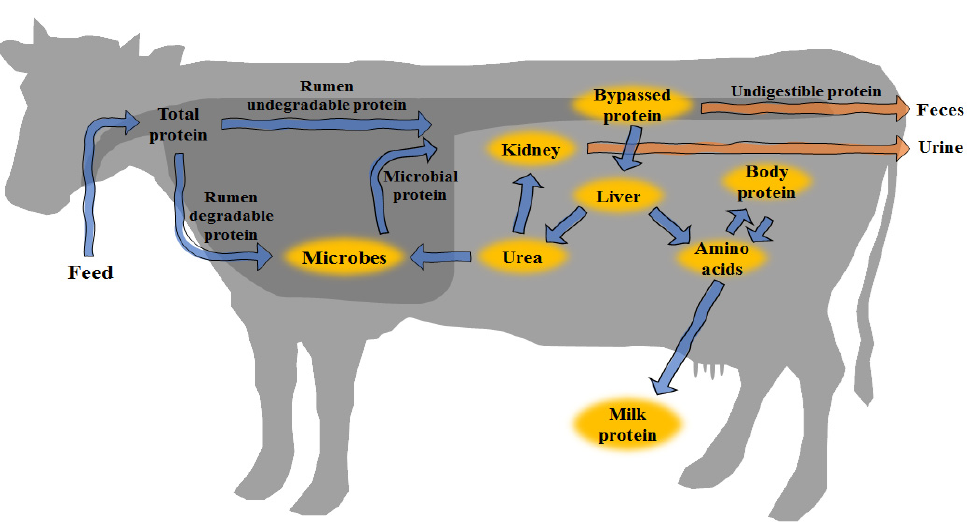
Figure 1. Protein metabolism of dairy